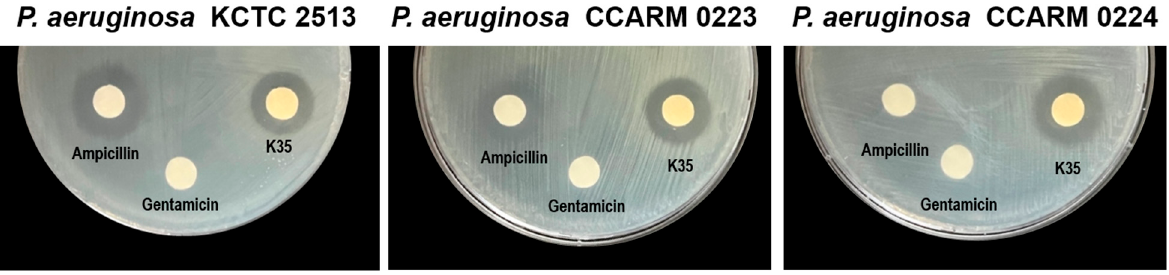
Figure 2. Antimicrobial activity by CFS of P. inopinatus K35 against P. aeruginosa KCTC 2513, CCARM 0223, and CCARM 0224. Table 2. Antimicrobial activity as diameter of inhibition zone of P. inopinatus K35 using disc diffusion assay. Data are presented as mean ± SD of the results from three replicates. * ND, non-detected.